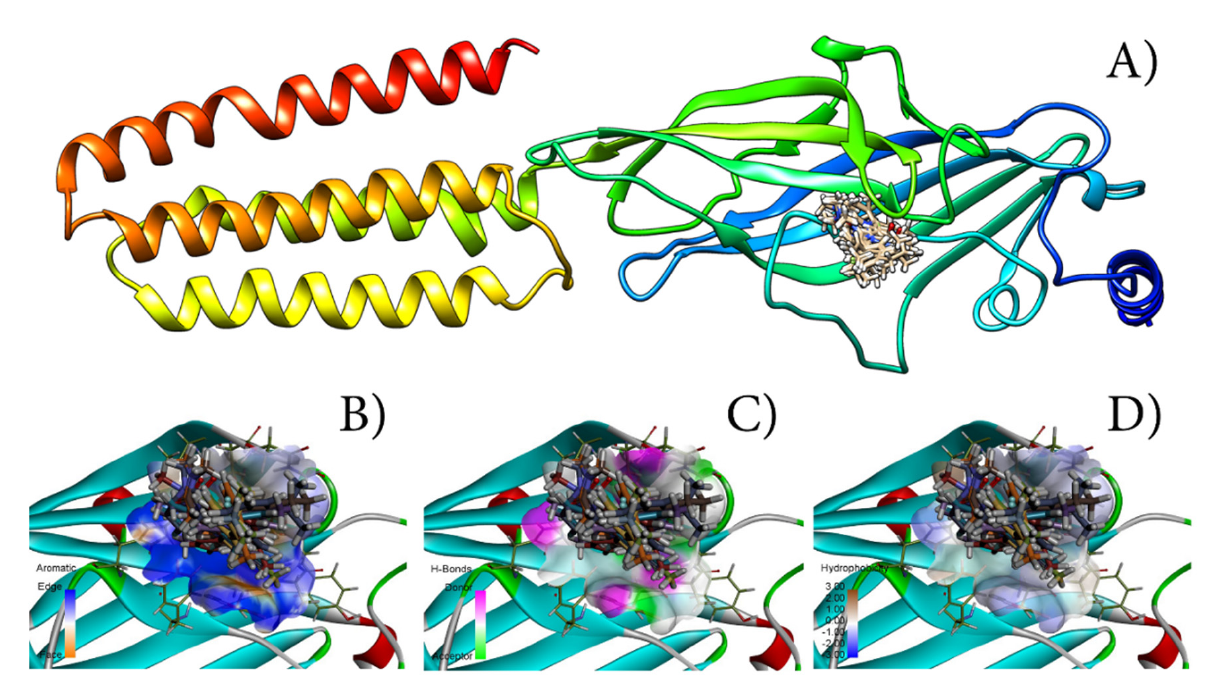
Figure 4. ( A ) Best calculated poses for all designed molecules inside the active site of α 1-containing GABAARs; ( B ) Aromatic interactions inside active site; ( C ) Hydrogen bonds related interactions inside active site; ( D ) Hydrophobic interactions inside active site.